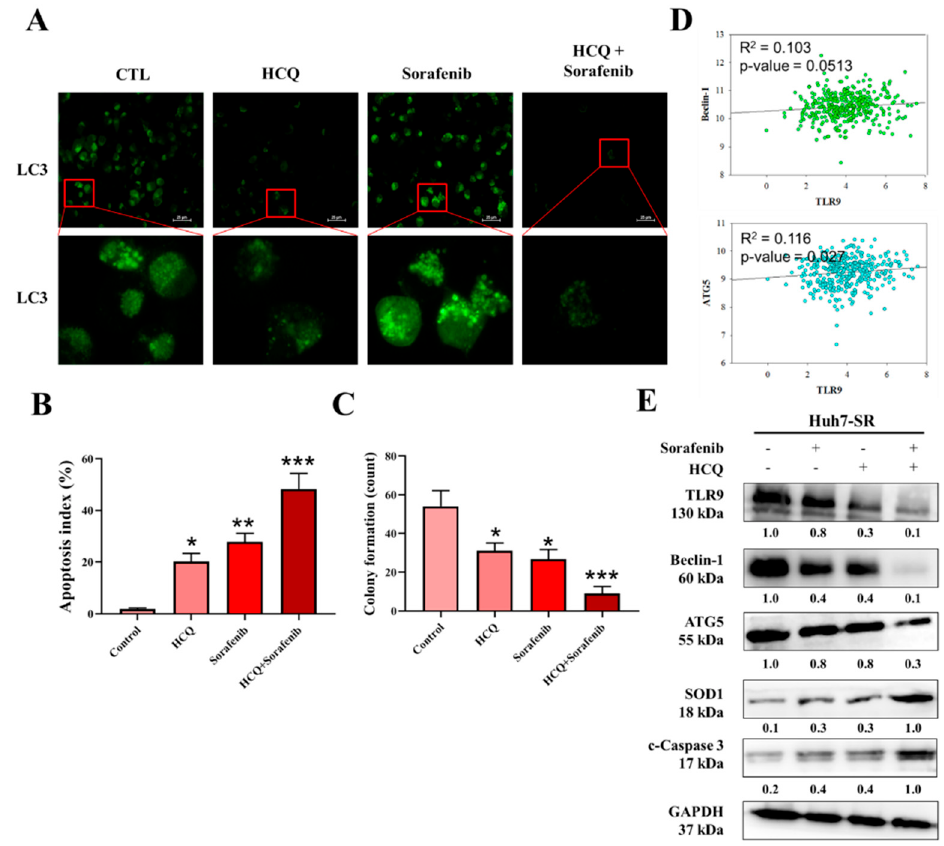
Figure 7. HCQ and sorafenib had a dual treatment effect and sensitized HCC sorafenib-resistant cells in vitro. ( A ) Autophagy body formation was assayed by fluorescence microscopy after staining. ( B ) FACS profile of annexin V/7-AAD staining of Huh7-SR cells undergoing apoptosis induced by HCQ (5 μ M) and sorafenib alone (5 μ M) or in combination (both the agents at 5 μ M). ( C ) Reduction in self-renewal ability, a significant reduction in the colony-forming abilities observed in combination treatment. ( D ) Correlation analysis of TLR9 expression with autophagy-related marker expression (R 2 = 0.103 in Beclin-1 and R 2 = 0.116 in ATG5). ( E ) HCQ and sorafenib cotreatment against TLR9, ATG5, Beclin-1, SOD1, and c-caspase-3 expression levels were measured by Western blotting: * p < 0.05, ** p < 0.01, *** p < 0.001.